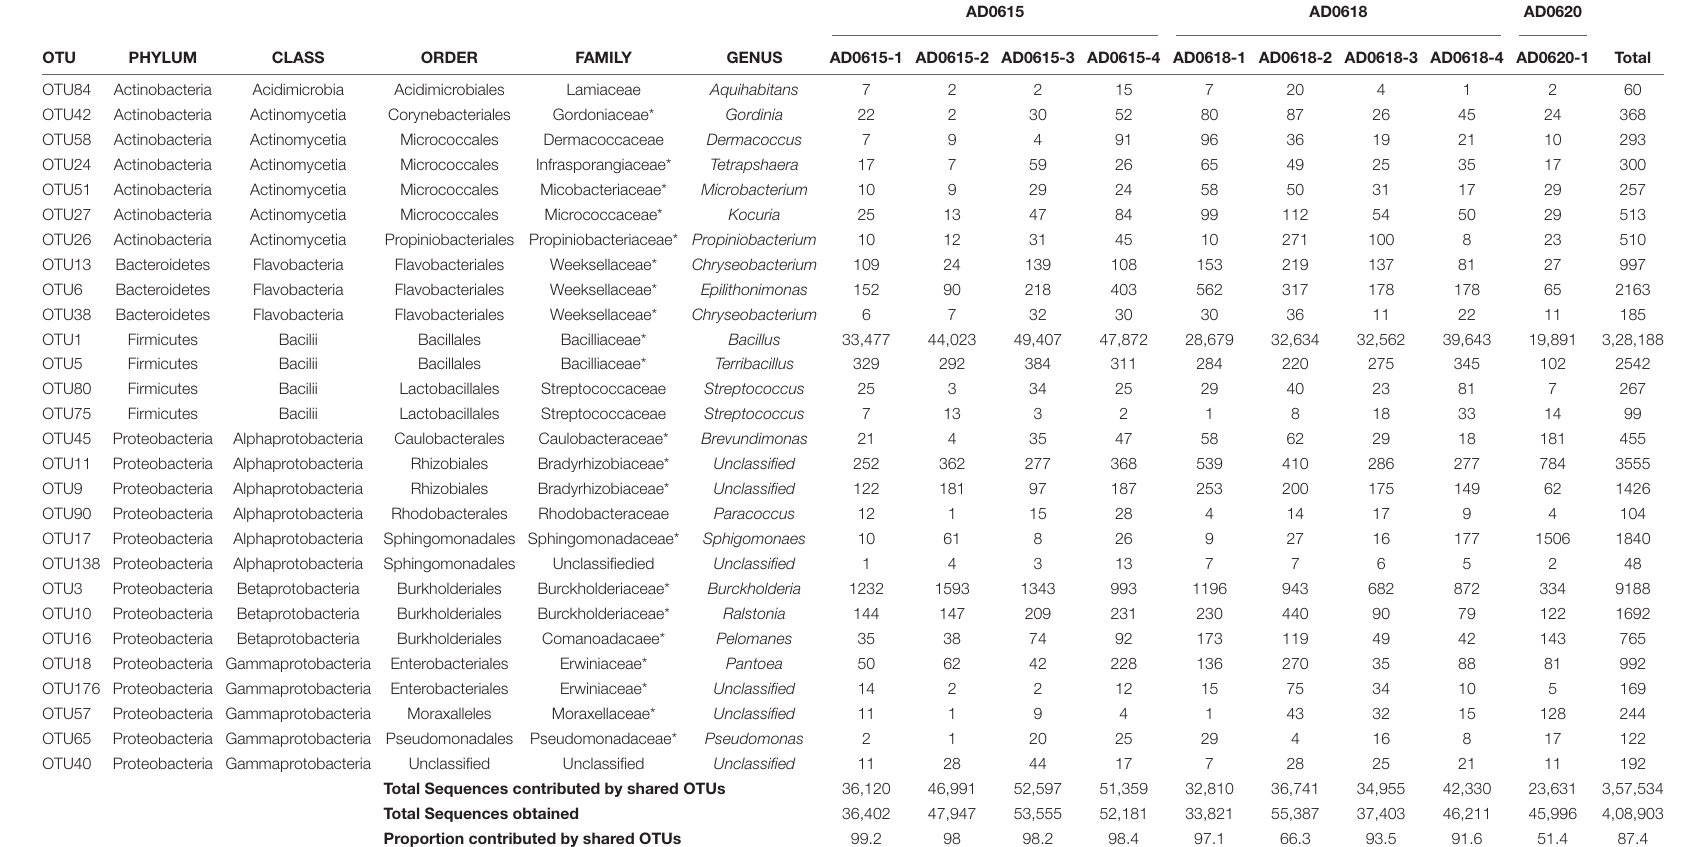
TABLE 2 | Summary of the 28 OTUs occurring in all